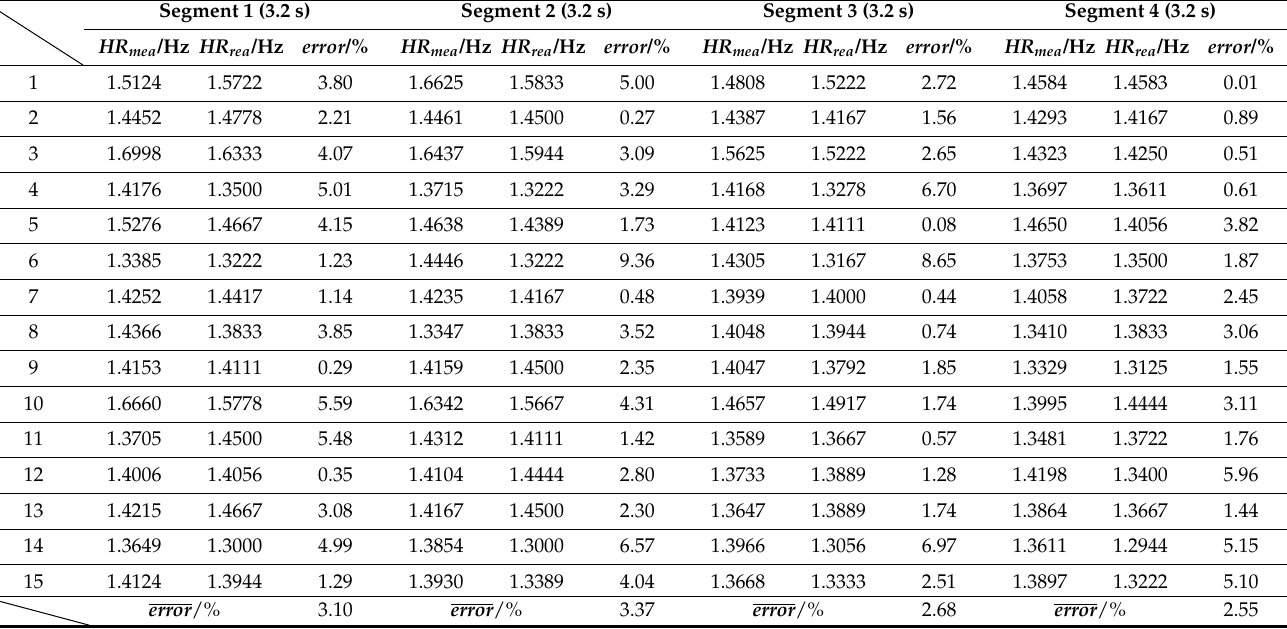
Table 1. Results of the experimental